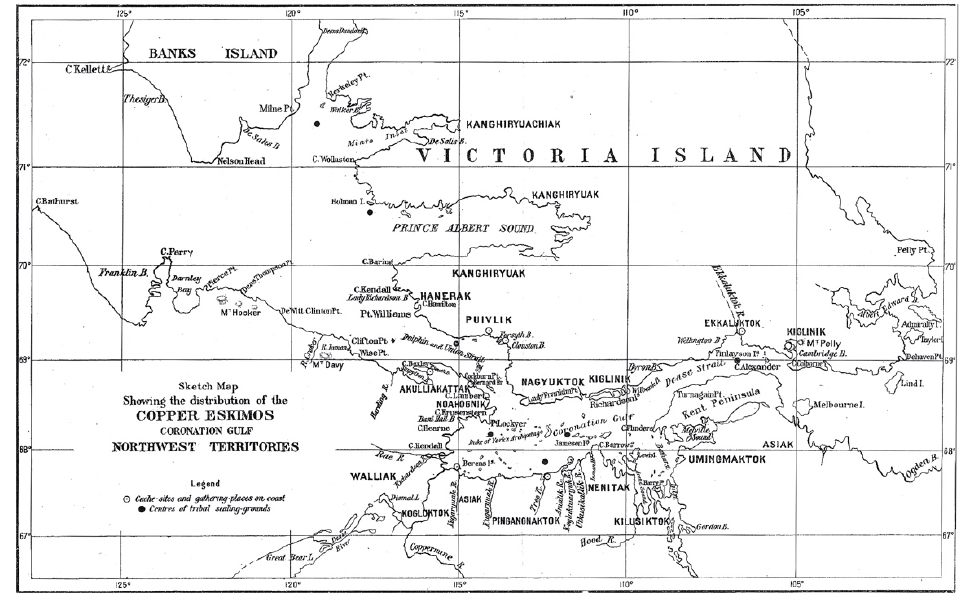
Figure 2. I A sketch map of the Inuinnait region in the Coronation Gulf surrounding Victoria Island in the Central Canada Arctic. Created by anthropologist Diamond Jenness for a 1921 ethnography [5] (287), this map provides the names of Inuinnait family groups who made up a total population of roughly 800 individuals at the time of Jenness’ census